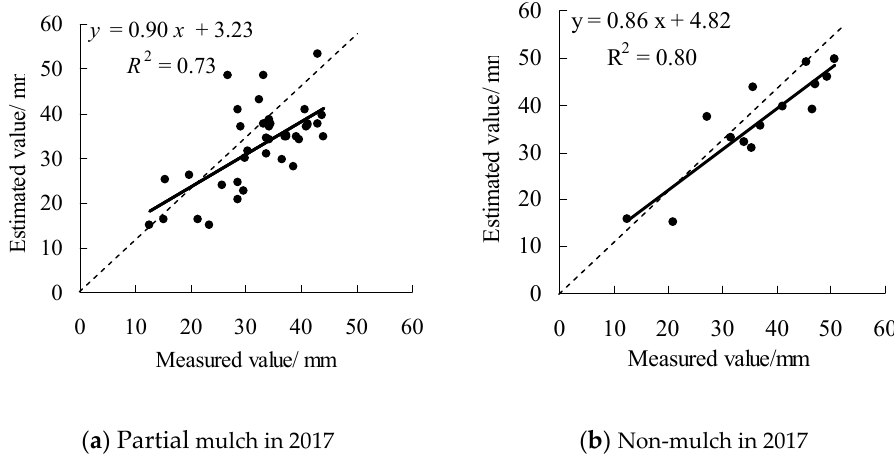
Figure 4. Regression between observed and estimated evapotranspiration in 2017 on partial mulched and non-mulched plots in Xinjiang, China. ( a ) Partial mulch in 2017; ( b ) Non-mulch in 2017. Table 5. Statistics of observed and estimated evapotranspiration in 2017 on partial mulched and non-mulched plots in Xinjiang, China.